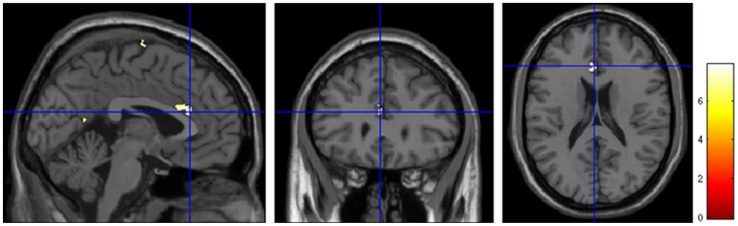
Regional gray matter volume reduction in recent onset PTSD compared with normal controls.The significant reduction regions in trauma survivors with recent onset PTSD (n = 10) compared with normal controls (n = 20) are rendered onto the standard T1 template of Montreal Neurological Institute. The trauma survivors with recent onset PTSD had a significantly decreased gray matter volume in the left ACC (p<0.05, FWE corrected, with k>50 voxels). ACC: anterior cingulate cortex.